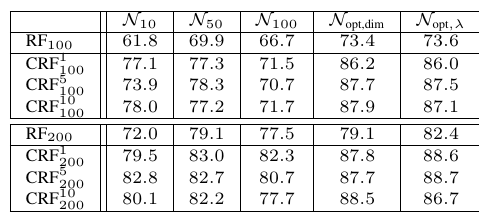
Table 6. Quality q [%] for class v achieved in all experiments.